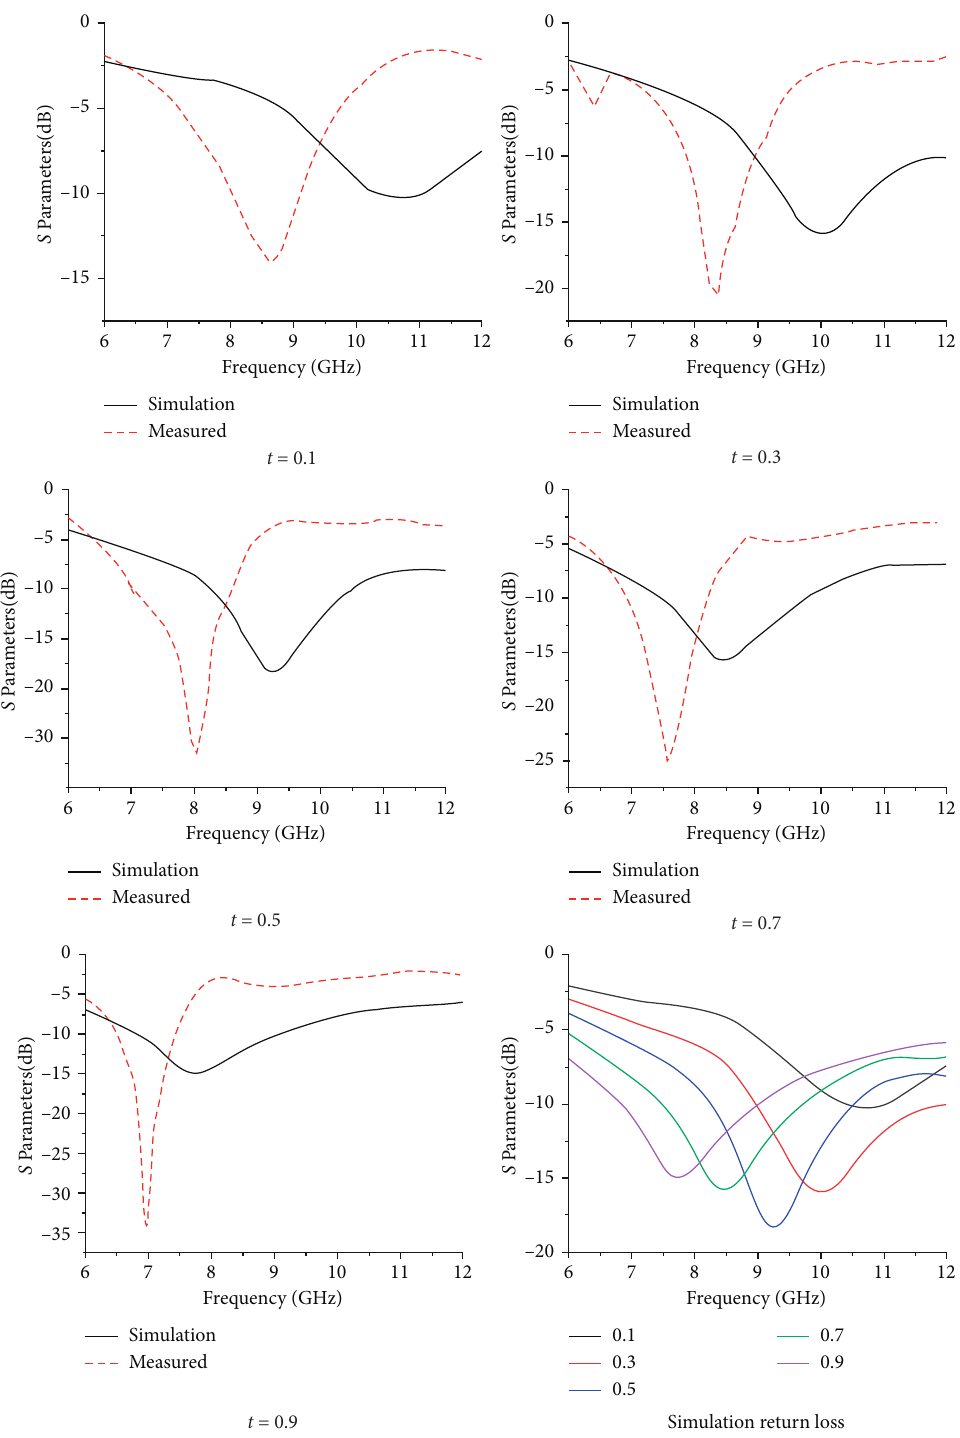
Figure 7: The results of return